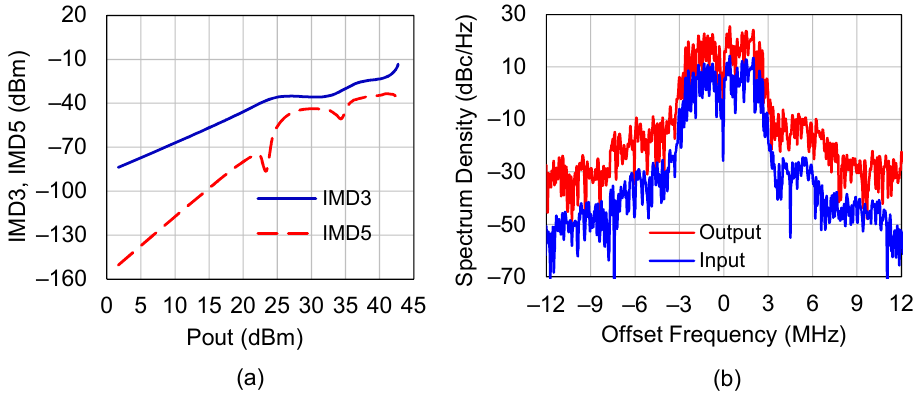
Figure 12. ( a ) Two-tone power sweep simulation at 3.3 GHz. ( b ) Simulated input and output power spectrum at 3.3 GHz for the average output power of 36 dBm. IMD, Intermodulation Distortion.